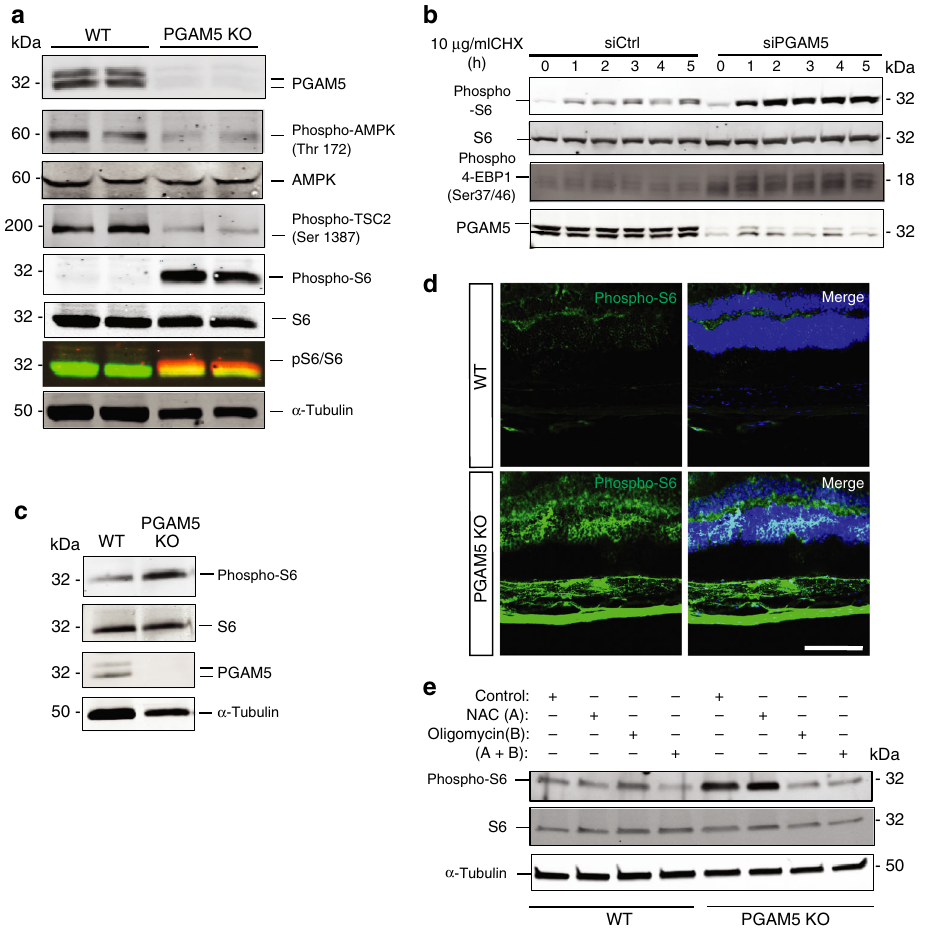
Fig. 4 Regulation of AMPK – mTOR pathway by PGAM5. a Expression of indicated proteins (PGAM5, phosphor-AMPK, total AMPK, phosphor-TSC2, phosphor-S6), total S6 in WT and PGAM5 − / − ARPE-19 cells by western blot after medium change for 48 h. Cells were cultured for 1 week. α -Tubulin was used as loading control. n = 3. b Expression of indicated proteins (PGAM5, phosphor-S6, total S6 and phosphor-4EBP1) in WT and PGAM5 silenced ARPE- 19 cells by western blot after treatment with 10 µ g/ml CHX for indicated times. n = 3. c Representative western blots showing increased phosphor-S6 but not total S6 protein in the RPE/choroid of Pgam5 − / − mice. α -Tubulin was used as loading control. n = 3. d Increased phosphor-S6 in retinal cryosections of Pgam5 − / − mice (2-months-old) compared to age-matched WT mice. Scale bar = 100 µ m. n = 3. e Phosphor-S6 and total S6 protein expression in WT and PGAM5 − / − ARPE-19 cells by western blot after medium change for 48 h and NAC (3 mM) and/or oligomycin (5 µ M) treatment for overnight. α -Tubulin was used as loading control. n = 3. For assays in the fi gure, n represents the number of biologically independent experiments. Images were captured under same settings, and representative images were shown. Source data are available as a Source Data fi